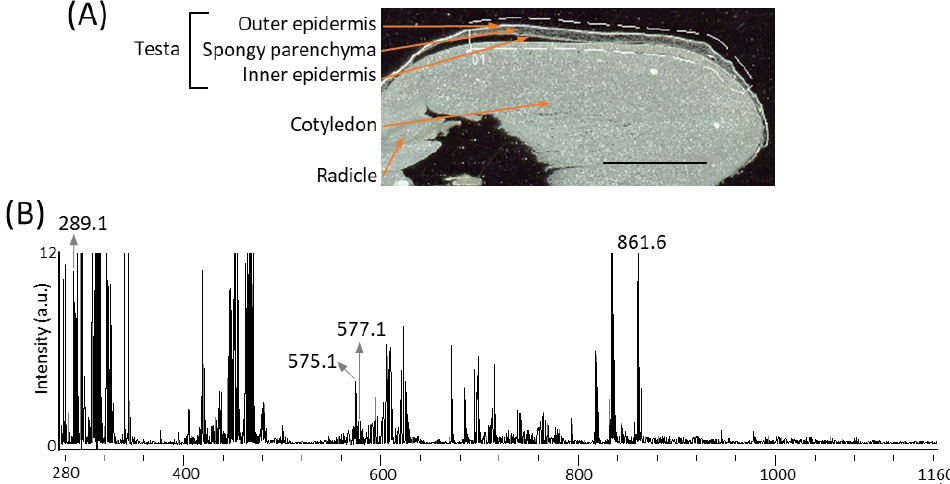
Figure 2. Matrix assisted laser desorption / ionization (MALDI)-mass spectrometry imaging (MSI) of a peanut longitudinal section. ( A ) Optical image of a peanut fruit section before MALDI–MSI measurement. The dotted white line shows the analyzed region. Scale bar = 5 mm. ( B ) Mass spectrum obtained from the peanut section.